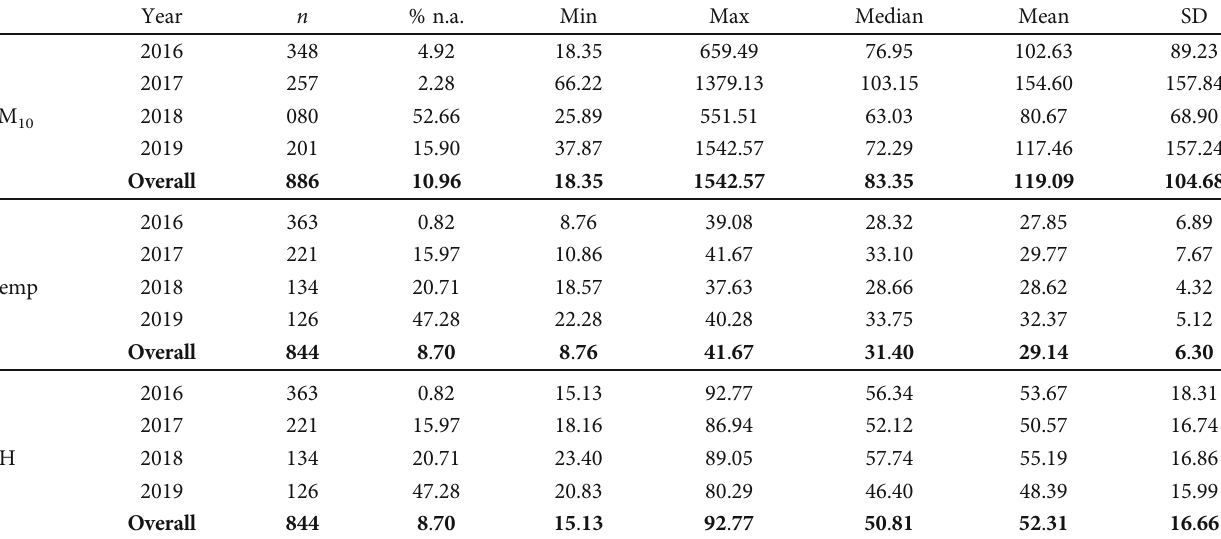
Table 1: Summary statistics of the daily PM pollutant measured in μ g/m 3 , temperature (denoted by Temp) measured in degree Celsius, 10 and relative humidity (RH) obtained by air pointer and the meteorological station at Qatar University site. n and SD stand for sample size and standard deviation, respectively. The % n.a. denotes the percentage of missing values in the data. n % n.a.